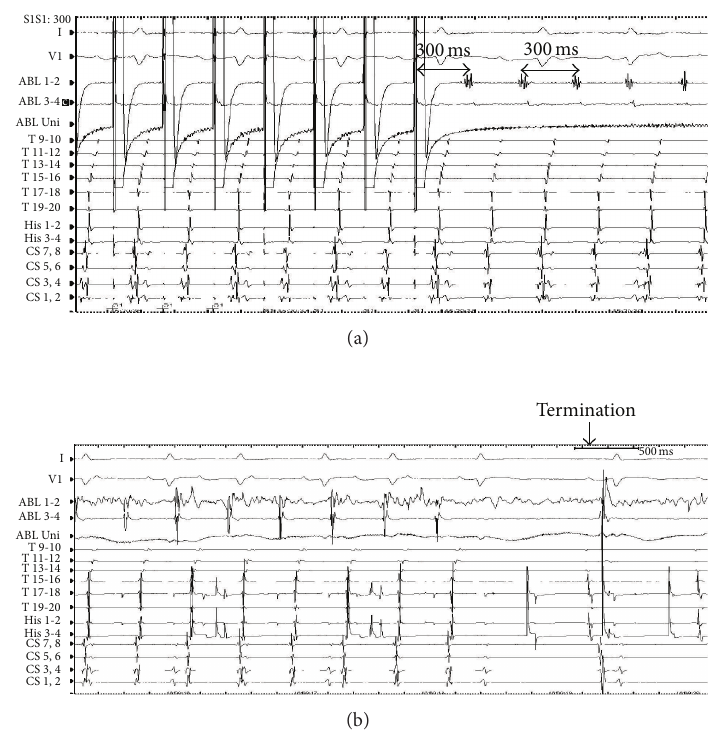
Figure 3: (a) Entrainment pacing at the LA roof with a stimulation interval of 290 ms slow conduction area as shown in Figure 2(a). The postpacing interval was the same as the AT cycle length. (b) The AT termination during the linear